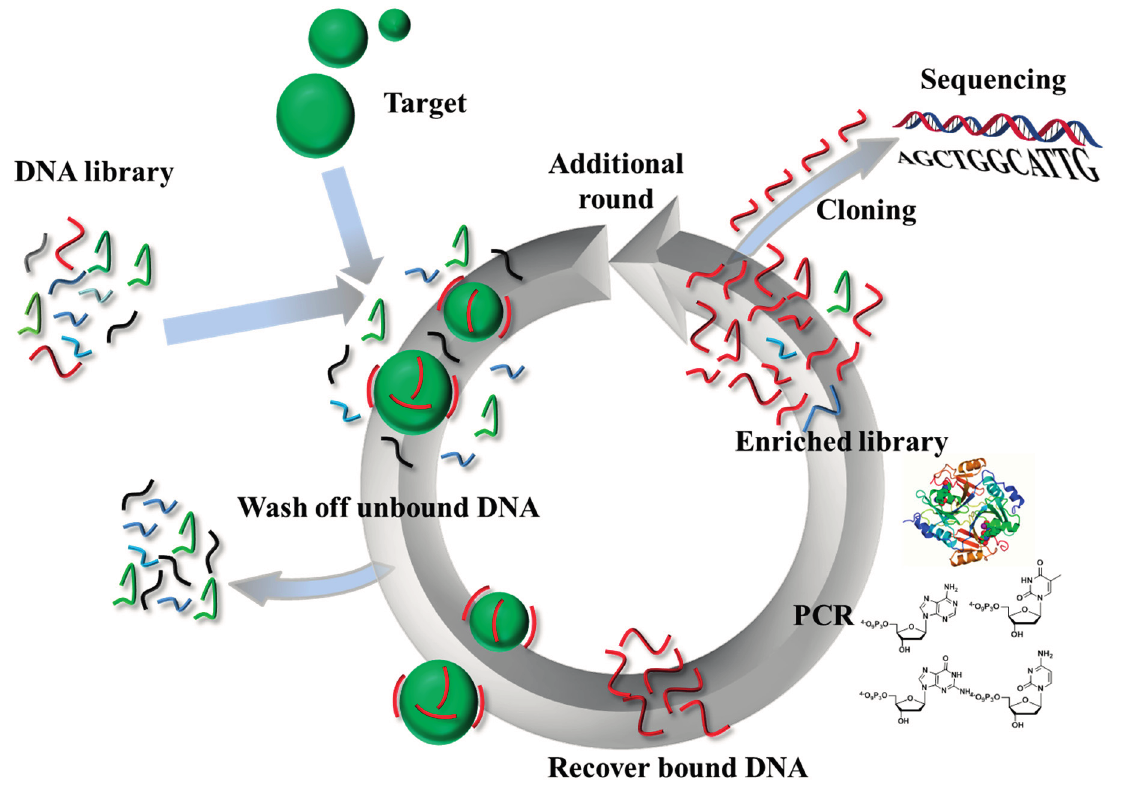
Figure 1. Schematic representation of the SELEX strategy for the identification of DNA